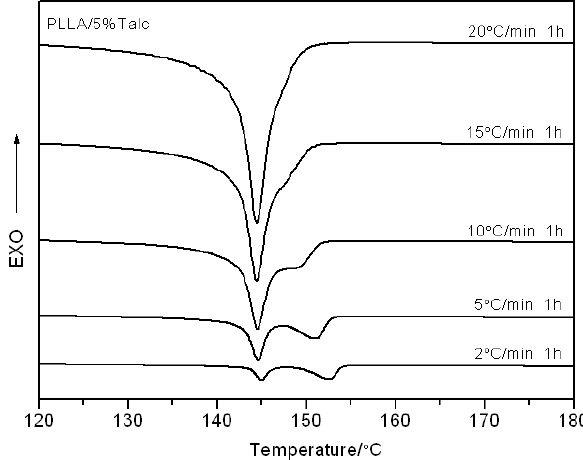
Figure 3. Melting behavior of PLLA/5%talc composites at different heating rate during isothermal crystallization for 1h at 100 ℃